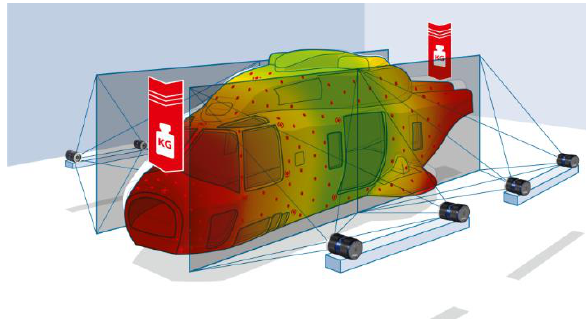
Figure 30: Deformation